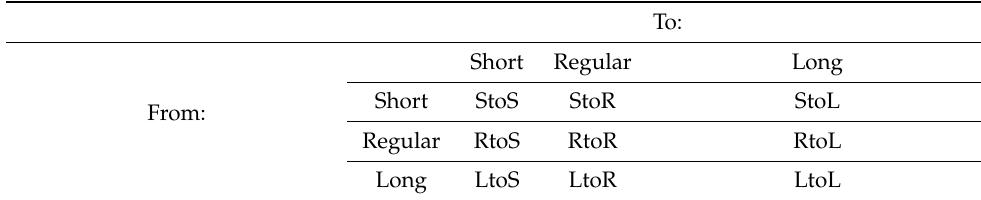
Table 1. Illustration of the R-R interval transition matrix.